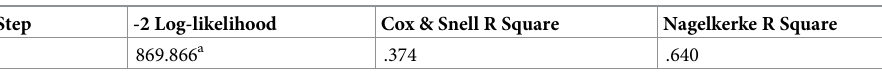
Table 6. Model summary.